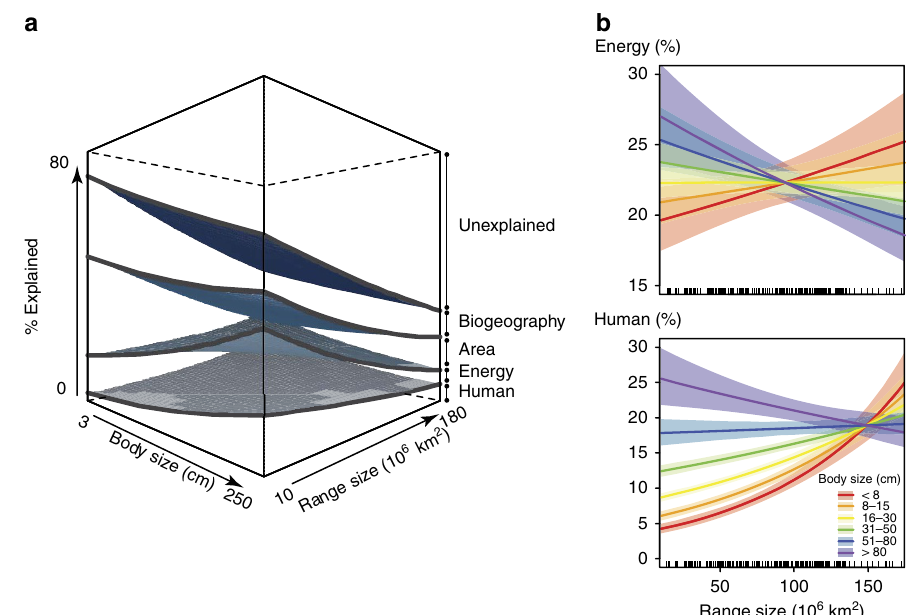
Figure 1 | Influence of body size, geographic range size and their interactions, on fish occurrence patterns. ( a ) Percent variation explained in species probability of occurrence by biogeography, energy (temperature and primary productivity), area, and human pressure, and as a function of maximum adult total length (body size, in cm; log scale) and geographic extent of occurrence (geographic range size, in 10 6 km 2 ). ( b ) Relationship between geographic range size and the relative contribution of energy (top) and human pressure (bottom) to the variation explained in fish occurrence patterns as a function of maximum adult body size. Envelopes indicate 95% confidence